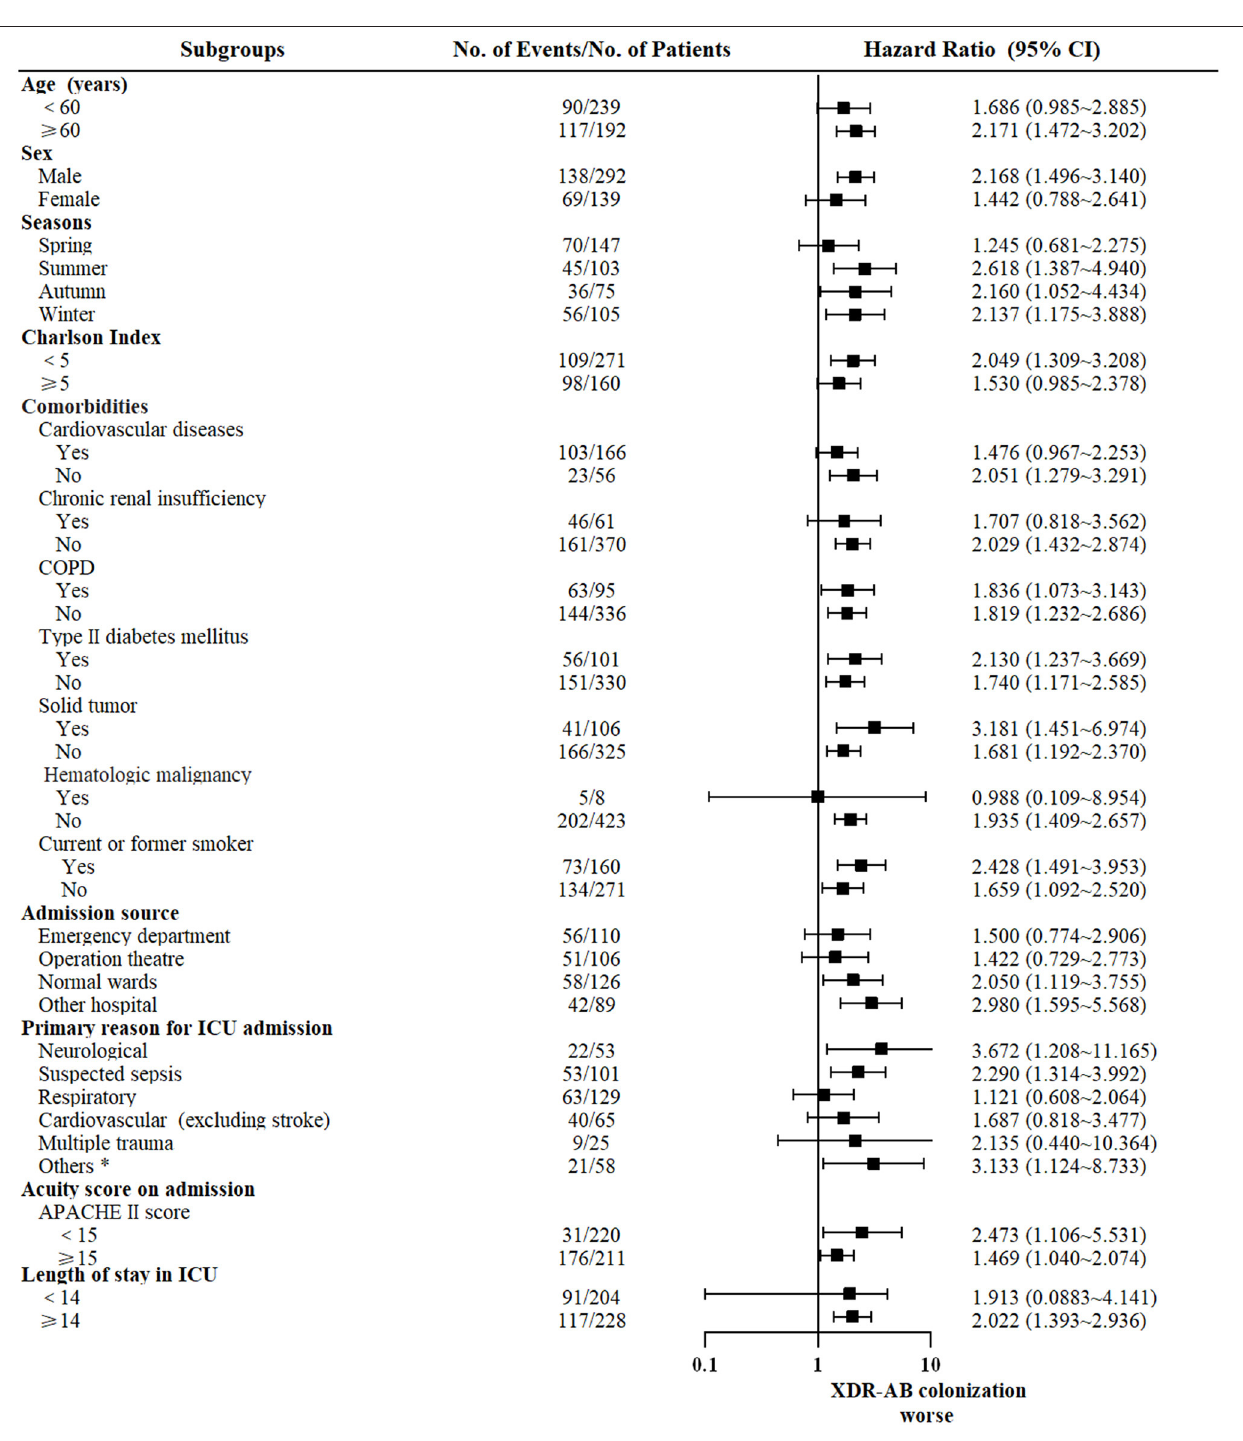
Increase in mortality caused by XDR-AB colonization indicates the need for essential surveillance during the early stage and efficient measures of